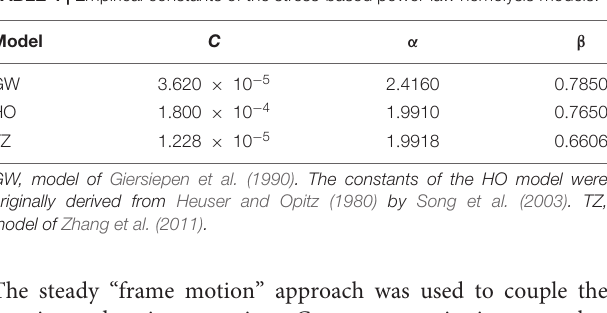
TABLE 4 | Empirical constants of the stress-based power-law hemolysis